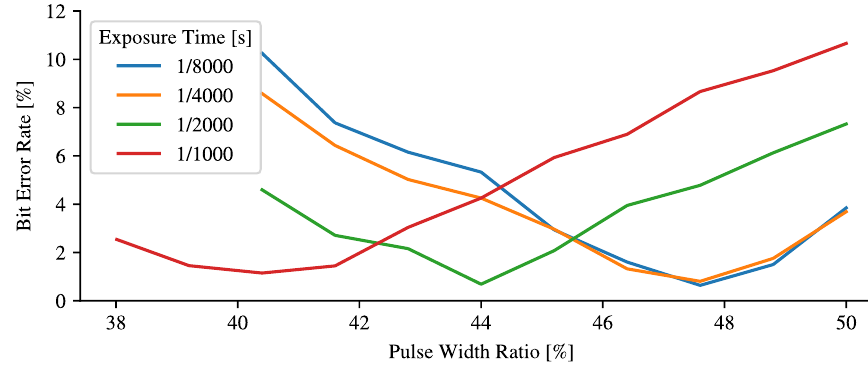
Figure 15. BER depending on pulse width ratio for different exposure settings.